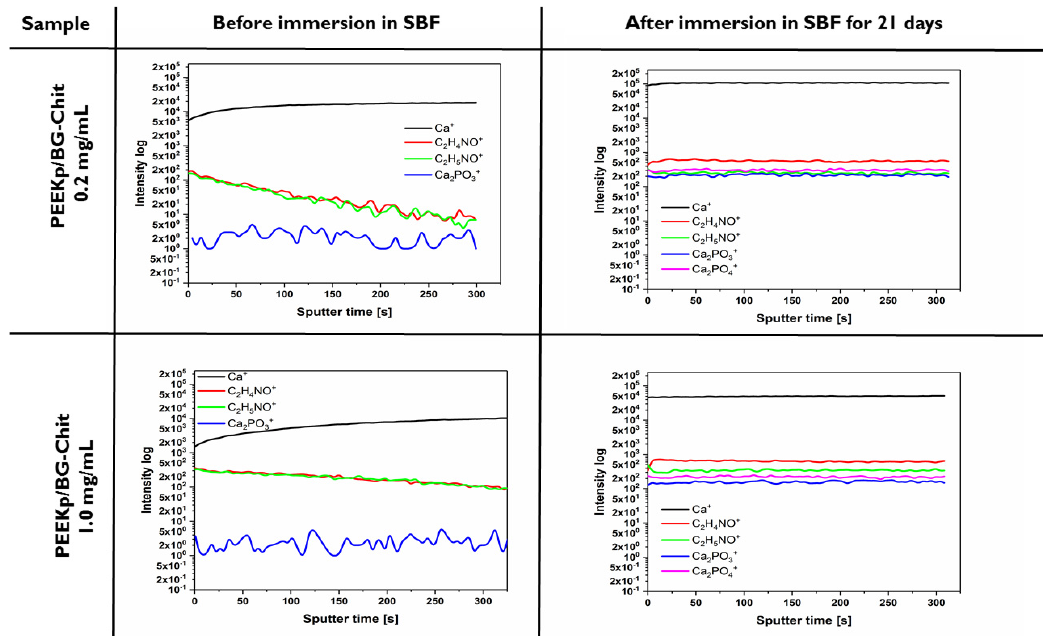
Figure 12. Depth profiles determined before and after the incubation in SBF for PEEKp/BG-Chit 0.2 and 1.0 mg/mL systems.